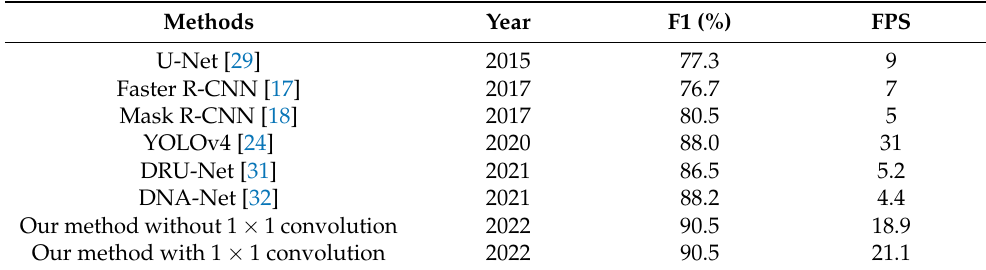
Table 4. Frame rate comparison results.